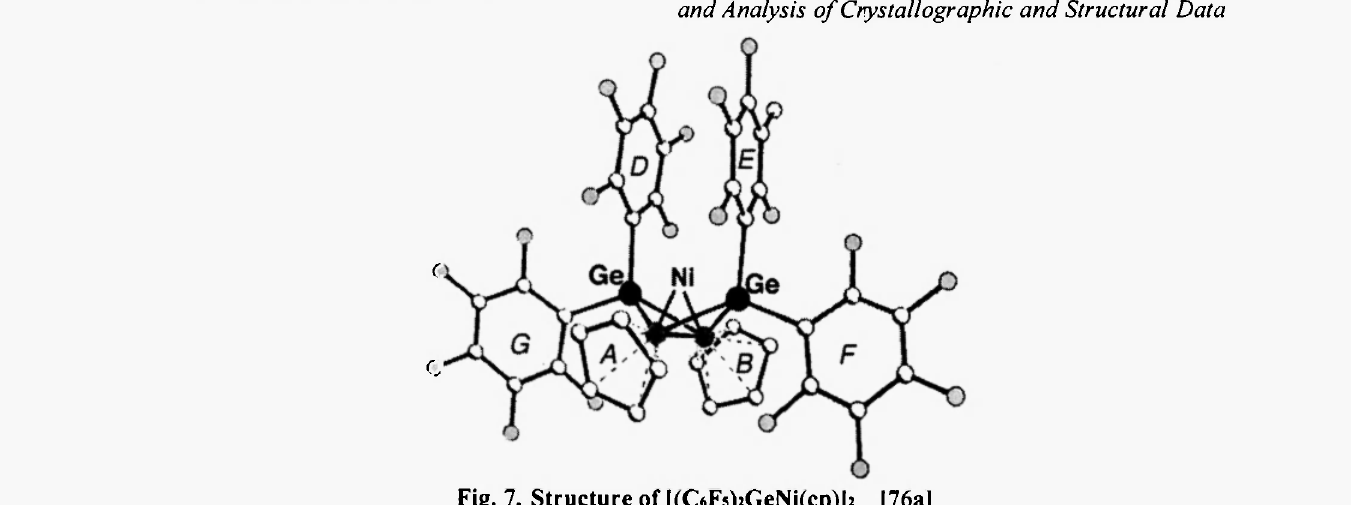
Fig. 7. Structure of |(C«Fs )2GeNi (cp )|2